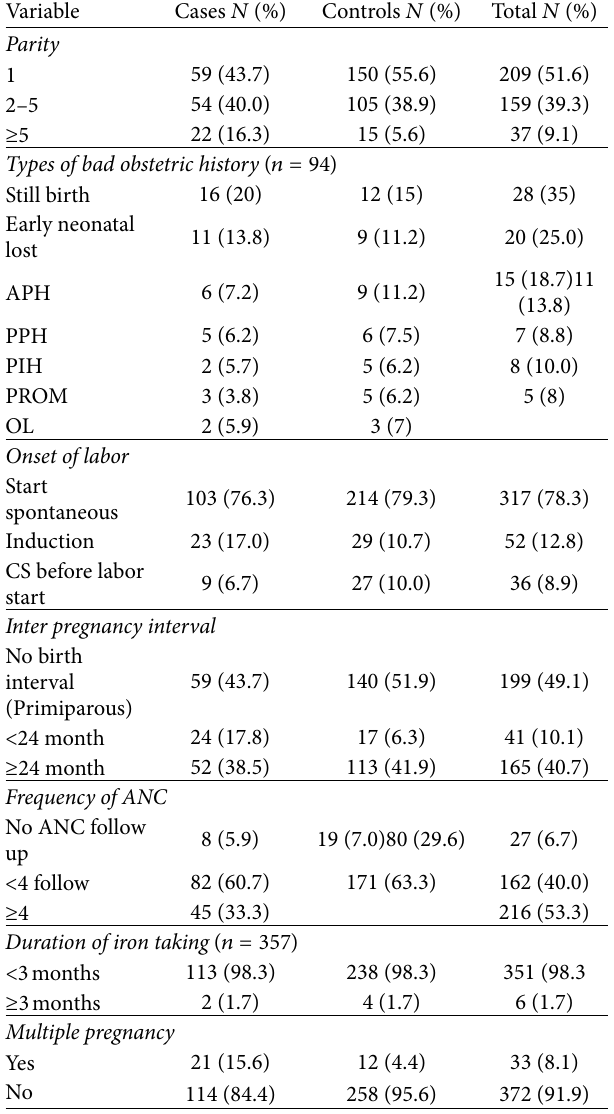
Table 2: Obstetrics profiles of study participants who gave birth in Amhara region, referral hospitals, Northwest, Ethiopia, 2019 ( 𝑛 = 450 ).